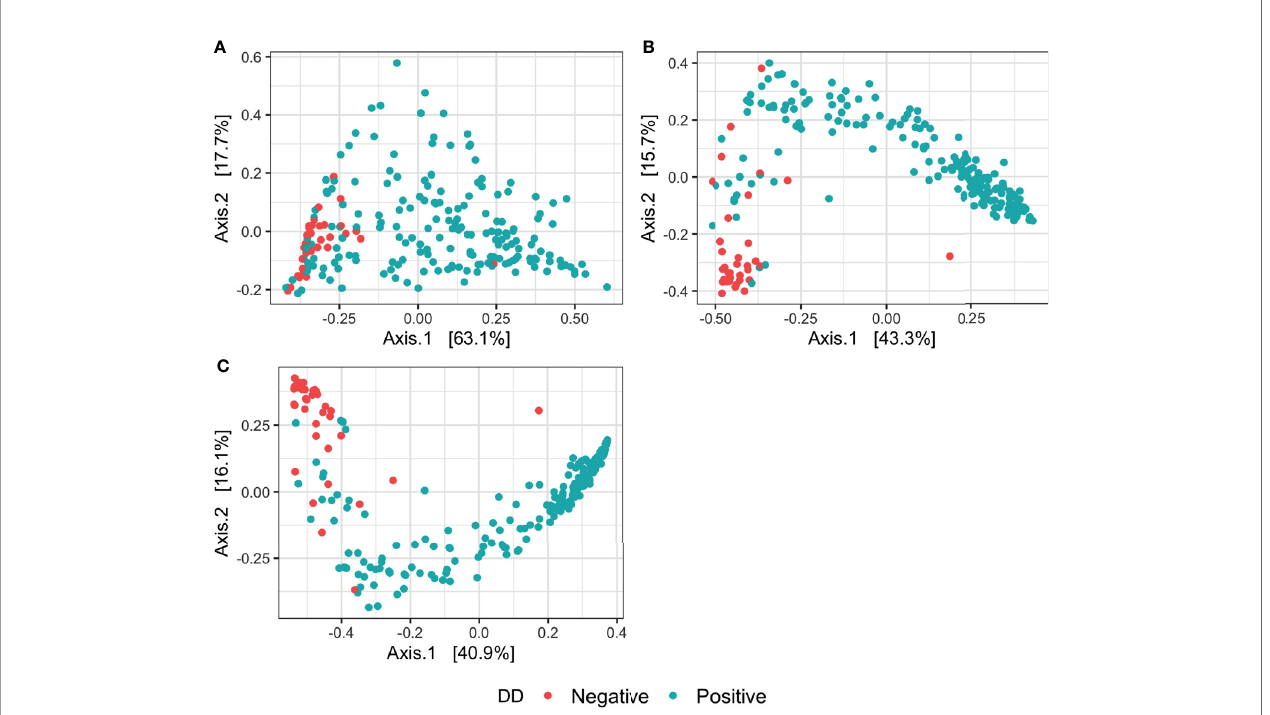
FIGURE 1 | Principal coordinates analysis of Bray-Curtis distances of the microbiota in DD negative and DD positive skin. Bray-Curtis distances were calculated on samples with ASVs grouped at three different taxonomic levels: (A) Phylum, (B) Family, (C)